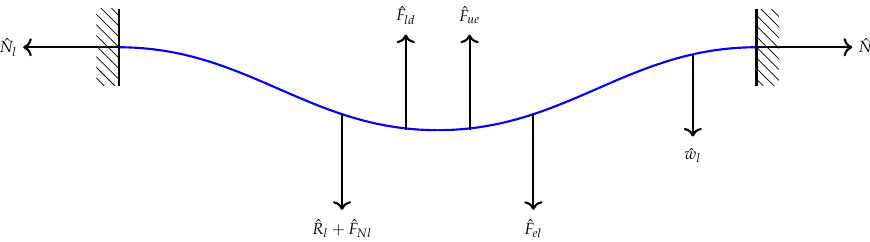
Figure 3. The F.B.D for the lower microbeam under the effect of electrostatic force, damping force, normal force and mid-pane stretching.